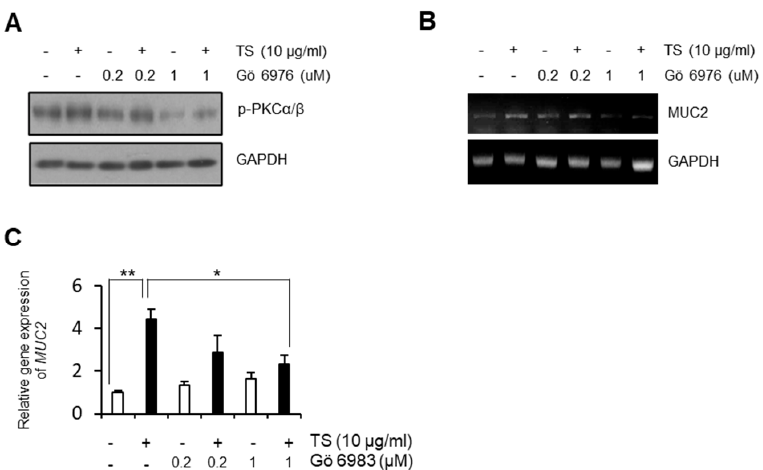
Figure 4. Effect of PKC inhibitors on the impact of trifostigmanoside I on LS174T cells. The PKC inhibitor suppressed TS-dependent MUC2 expression. ( A ) Expression of p-PKC α / β and GAPDH in LS174T cells after trifostigmanoside I treatment with or without Gö6976. ( B ) mRNA expression of MUC2 in LS174T cells after trifostigmanoside I treatment with or without Gö6976. ( C ) Semi-quantitative real-time PCR to assess the effect of pan-PKC inhibitor, Gö6983, on MUC2 expression. Data are presented as mean ± SEM of triplicate assays. All Western blot results were quantified by using Image J. * p < 0.05, ** p < 0.01. TS, trifostigmanoside